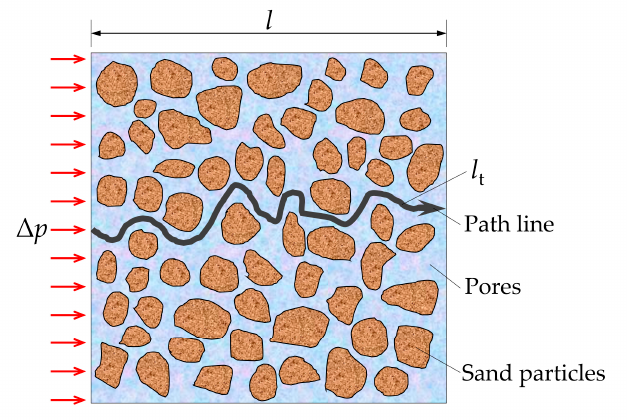
Figure 2. Schematic representing tortuosity.